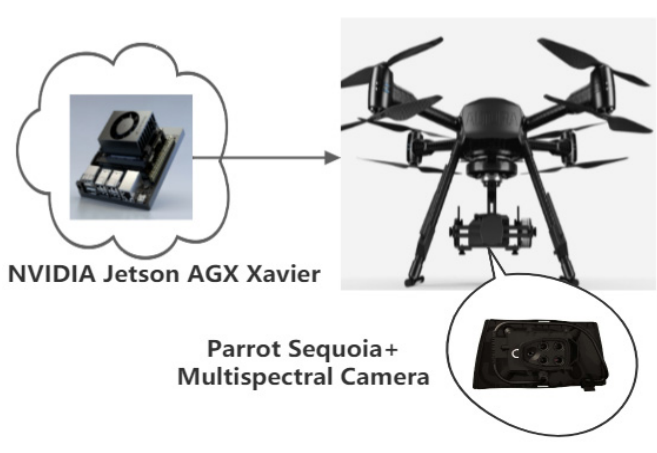
Figure 1. Drone with on-board GPU and multispectral camera. Table 1. Jetson AGX Xavier and Parrot Sequoia+ multispectral camera specification.